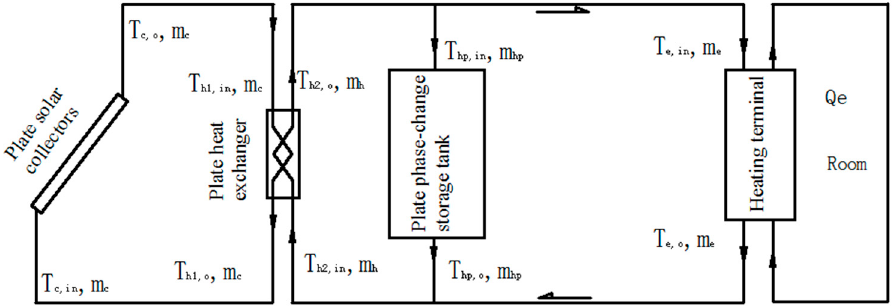
Figure 10. Operation model of the supply of heat from the solar collector to the room and phase-change thermal storage tank.